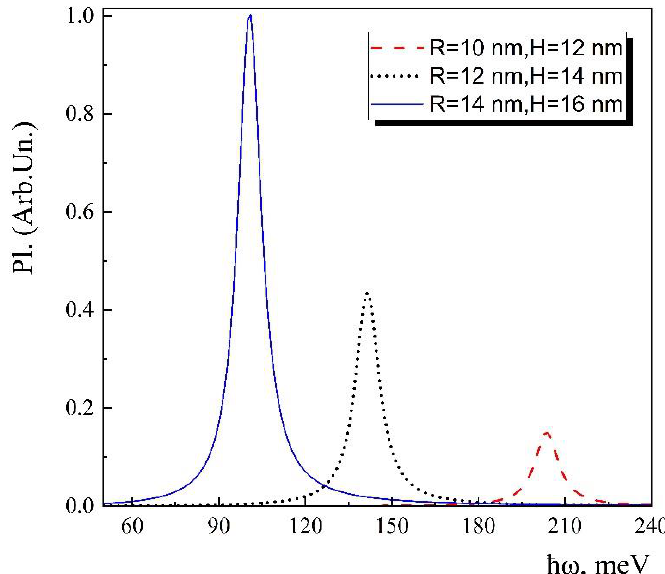
Figure 6. Dependence of the light energy of the PL spectra for different conical QD sizes at 4.2 K temperature.